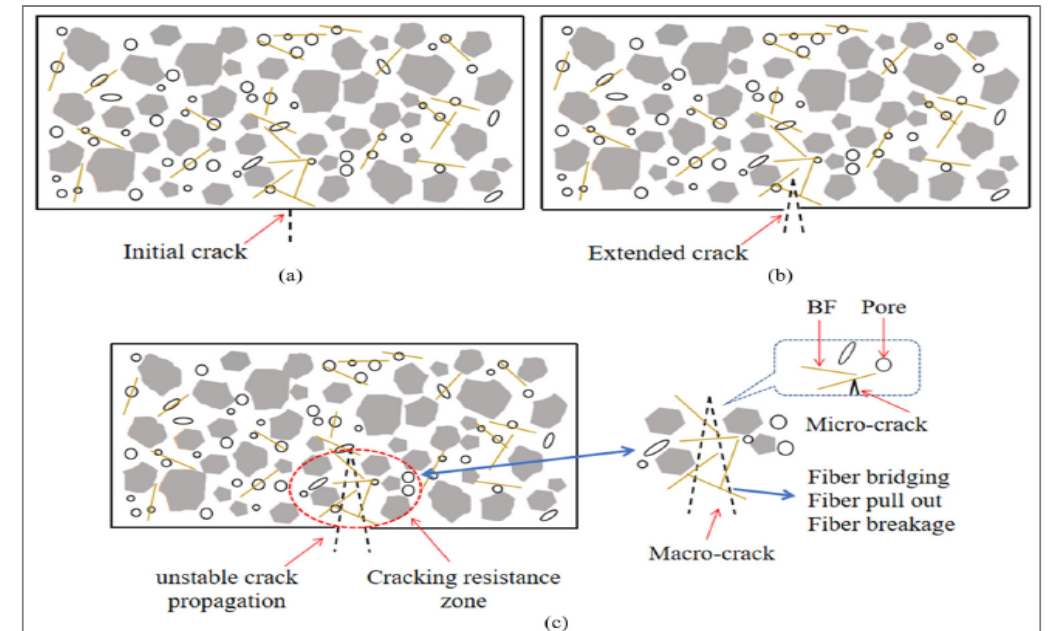
Figure 14. Flexural Failure Process of Basalt Fiber Reinforced Concrete: ( a ) Crack Initiation, ( b ) Crack Propagation, and ( c ) Toughening and Cracking [73].